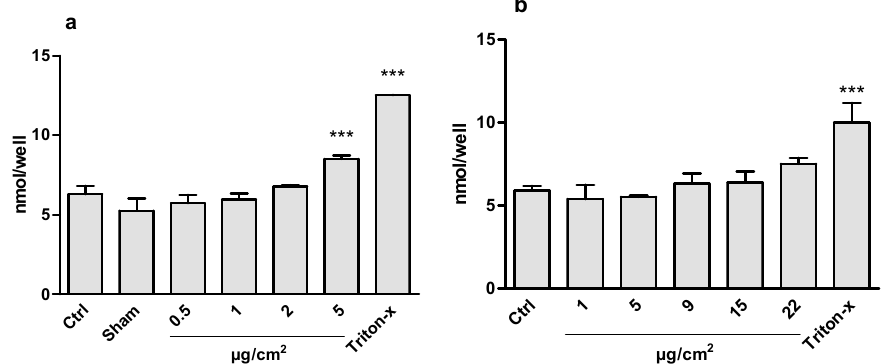
Figure 4. Cell viability analyzed by LDH assay in co-cultured A549 and THP-1 cells exposed to CeO 2 NPs for 24 h in air-liquid interface (ALI) ( a ) or in submerged ( b ) cell culture. Triton-x (0.1%) was used as positive control. Data is presented as the amount of NADH (nmol) generated by the supernatant at a given time, and is proportional to the LDH activity. The bars represent mean ± SD. Significant results, as compared to the Sham (clean air) for ALI and control (Ctrl) for submerged, are marked with asterisks (*** for p < 0.001).